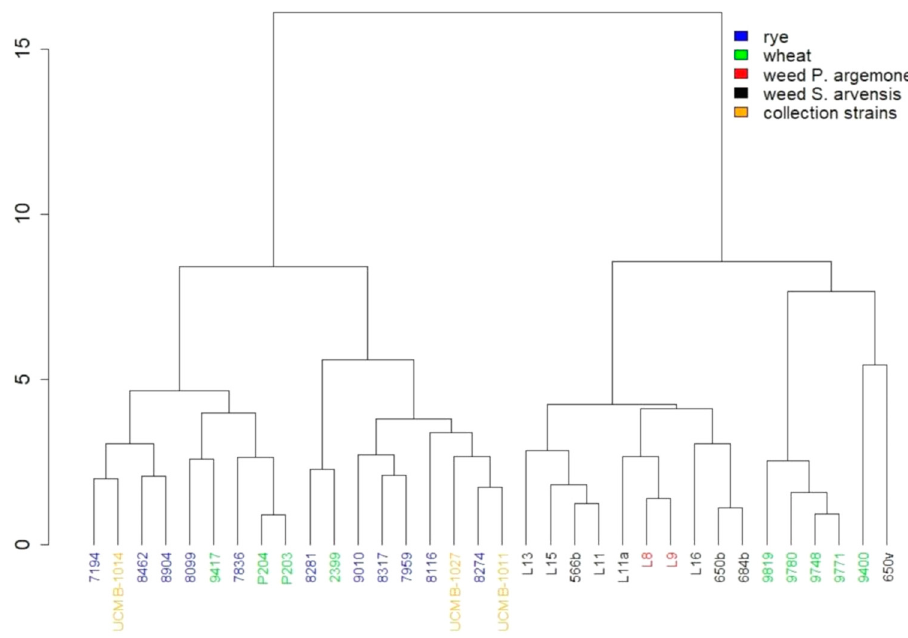
Figure 3. Cluster analysis of fatty acids composition of Pseudomonas syringae strains (Euclidean distance, Ward method).